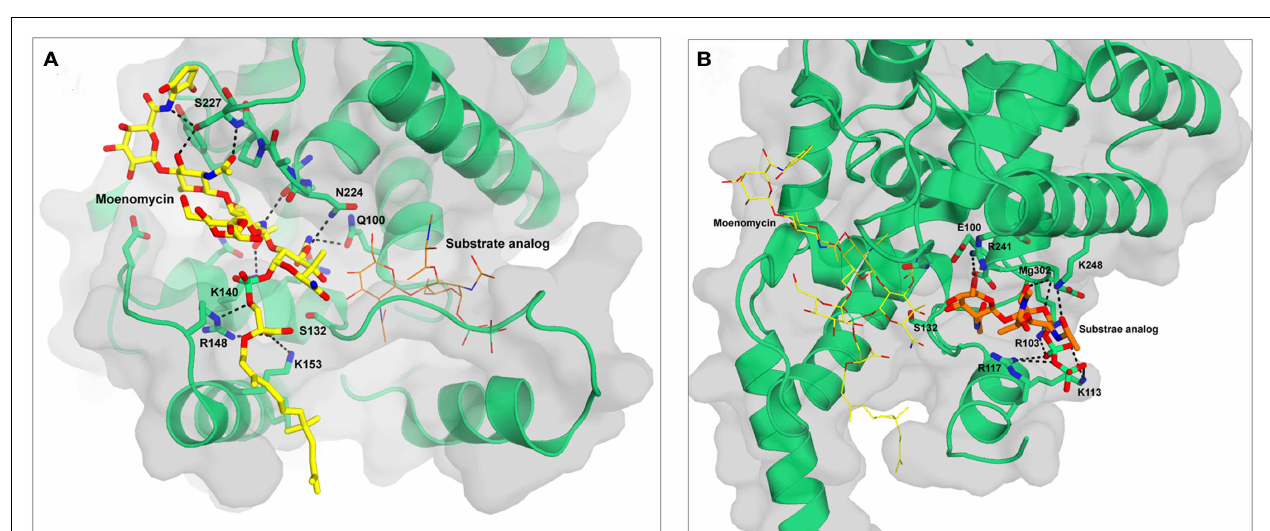
FIGURE 2 | Structures of S. aureus MtgA with moenomycin (A) and substrate analog 3 (B) bound in the donor and acceptor sites respectively. The figures are based on the pdb files 3HZS (A) and 3VMT (B) . Moenomycin is shown in yellow and the substrate analog in orange. Hydrogen bonds are shown as black dotted lines.The backbone atoms of residues 223–227 are shown as sticks to highlight the hydrogen bonds they form with